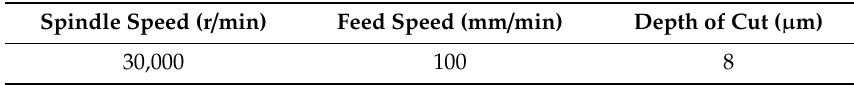
Figure 1. ( a ) Micro-milling machine tool and the milling cutter. ( b ) Geometrical dimensions of the microgrooves. Table 1. Cutting parameters in the micro-milling Table 1. Cutting parameters in the micro-milling process.